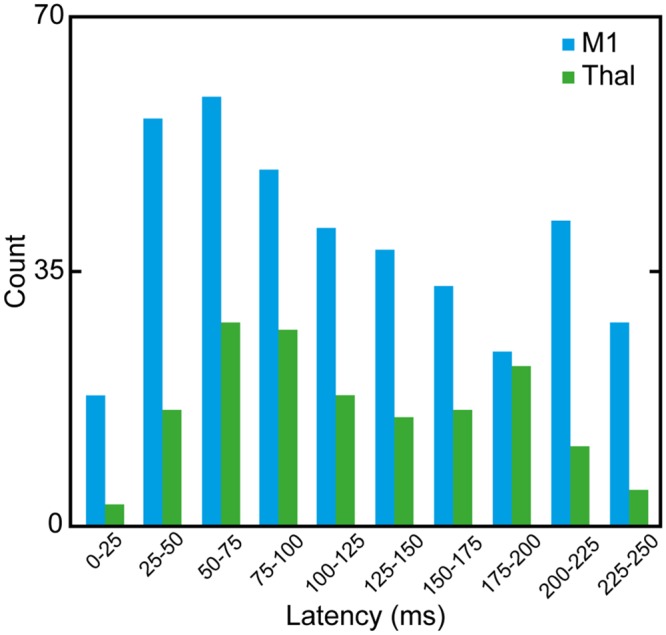
Histogram of onset latencies of contralateral hind limb EMG signals after FUS onset.Blue bars indicate the responses from M1 stimulation sessions while green bars indicate those from thalamic stimulation sessions.